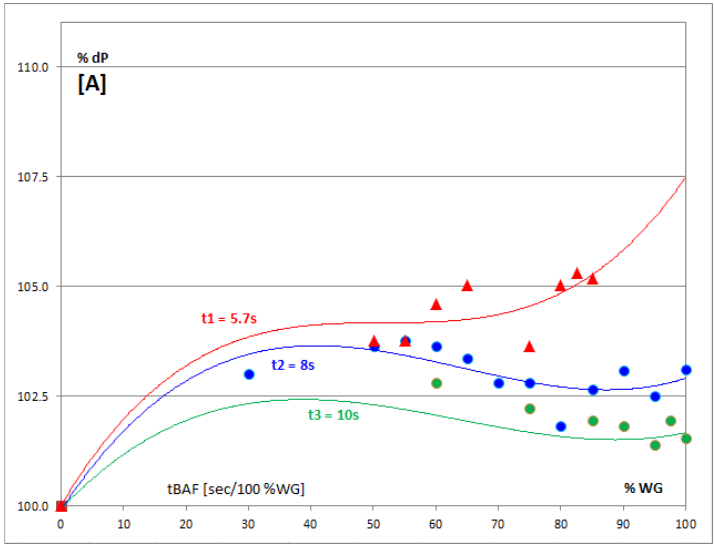
Figure 3. Overpressure function of wicket gate opening in load rejection at different tBAF for a propeller in the hydropower plant, tests performed in 2018 [88].